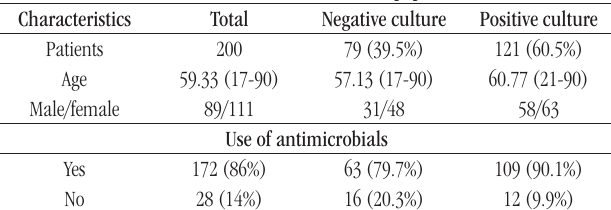
taBLE 1 − Characteristics of the population